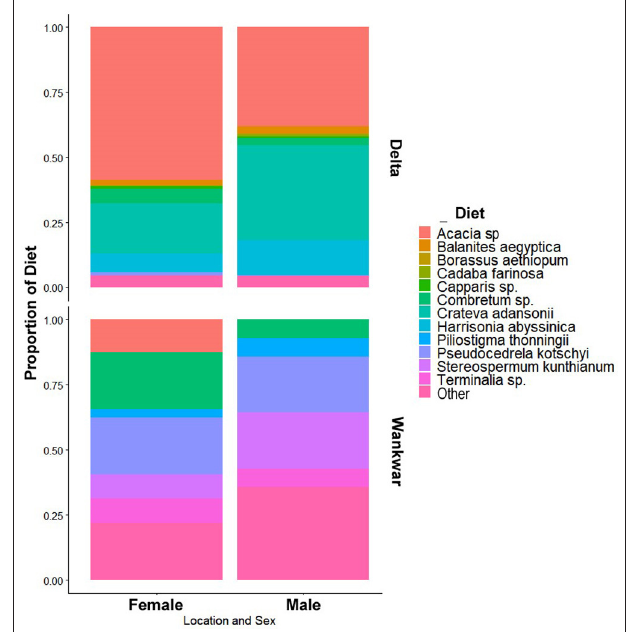
FIGURE 7 | The diet composition across sex classes and geographic location. We found significant differences in all pairwise comparisons except for male and female diets in Wankwar